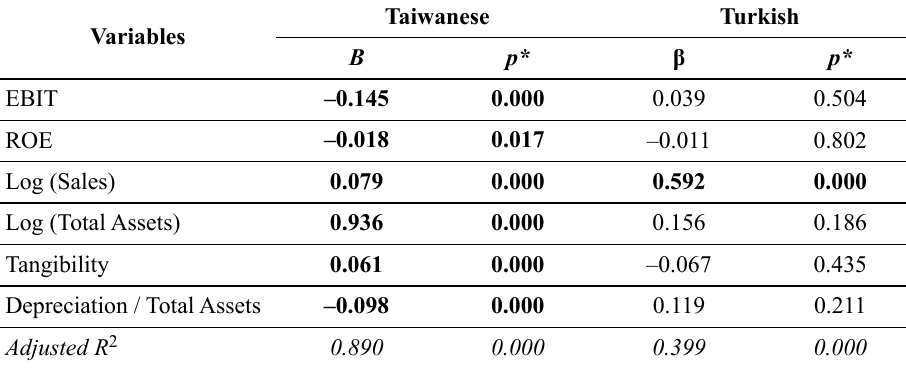
Table 3. Effects on the Total Debts / Total Assets ratio (TD / TA)